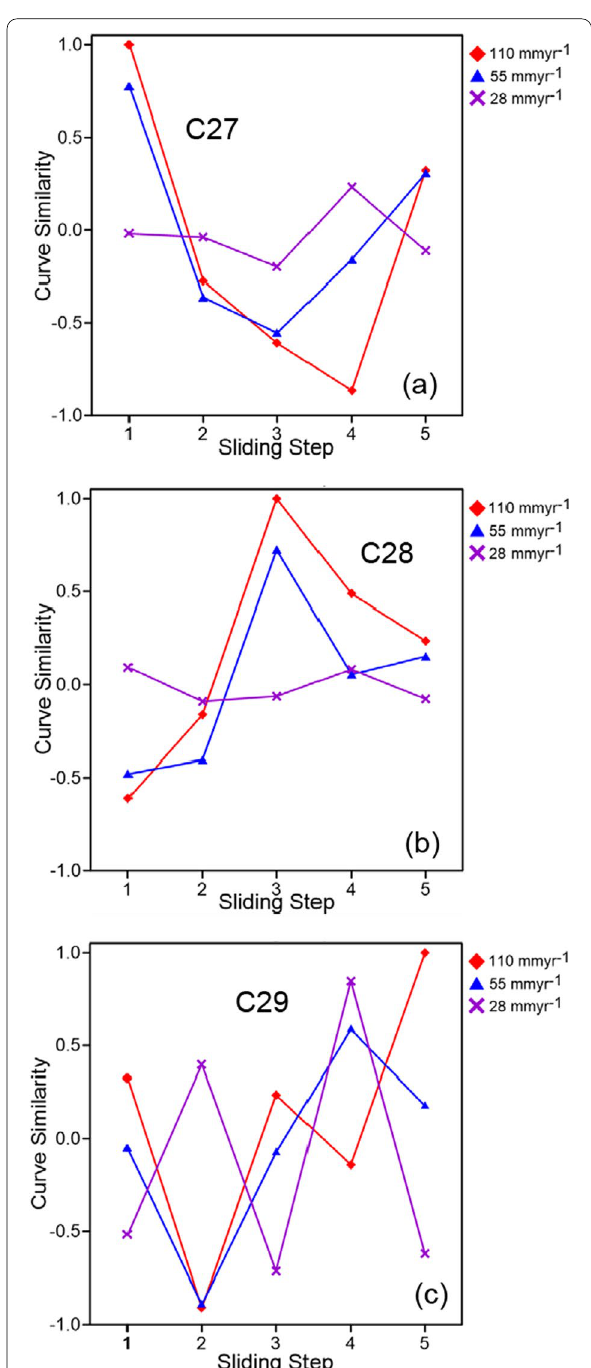
Fig. 9 Identification results of the polarity chron C27, C28 and C29 under different spreading rates of 110 mmyr − 1 , 55 mmyr − 1 and 28 mmyr − 1 . a The identification results of the polarity chron C27; b The identification results of the polarity chron C28; c The identification results of the polarity chron